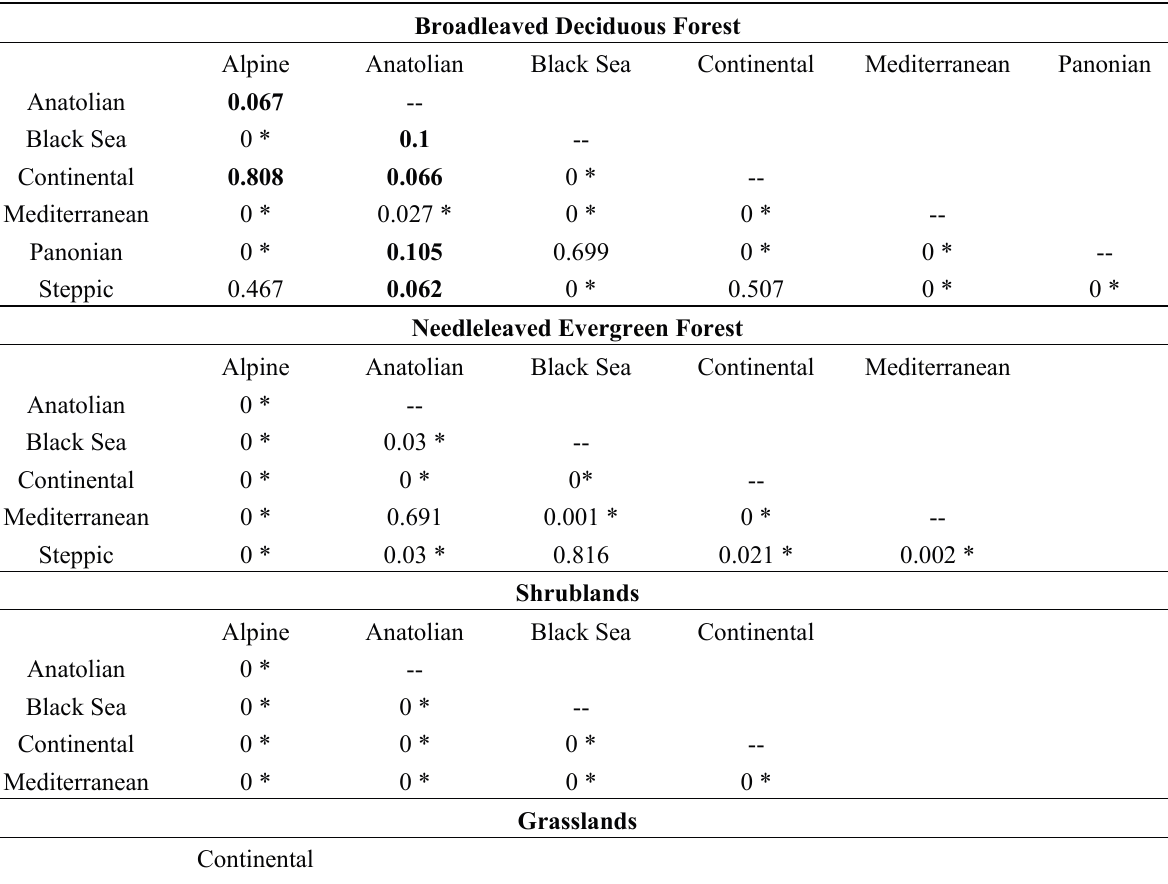
Table 2. p -values obtained from a two-tailed t -test between the OG of different biogeographical regions. Biogeographical regions with non-significant differences in both OG and EOS are given in